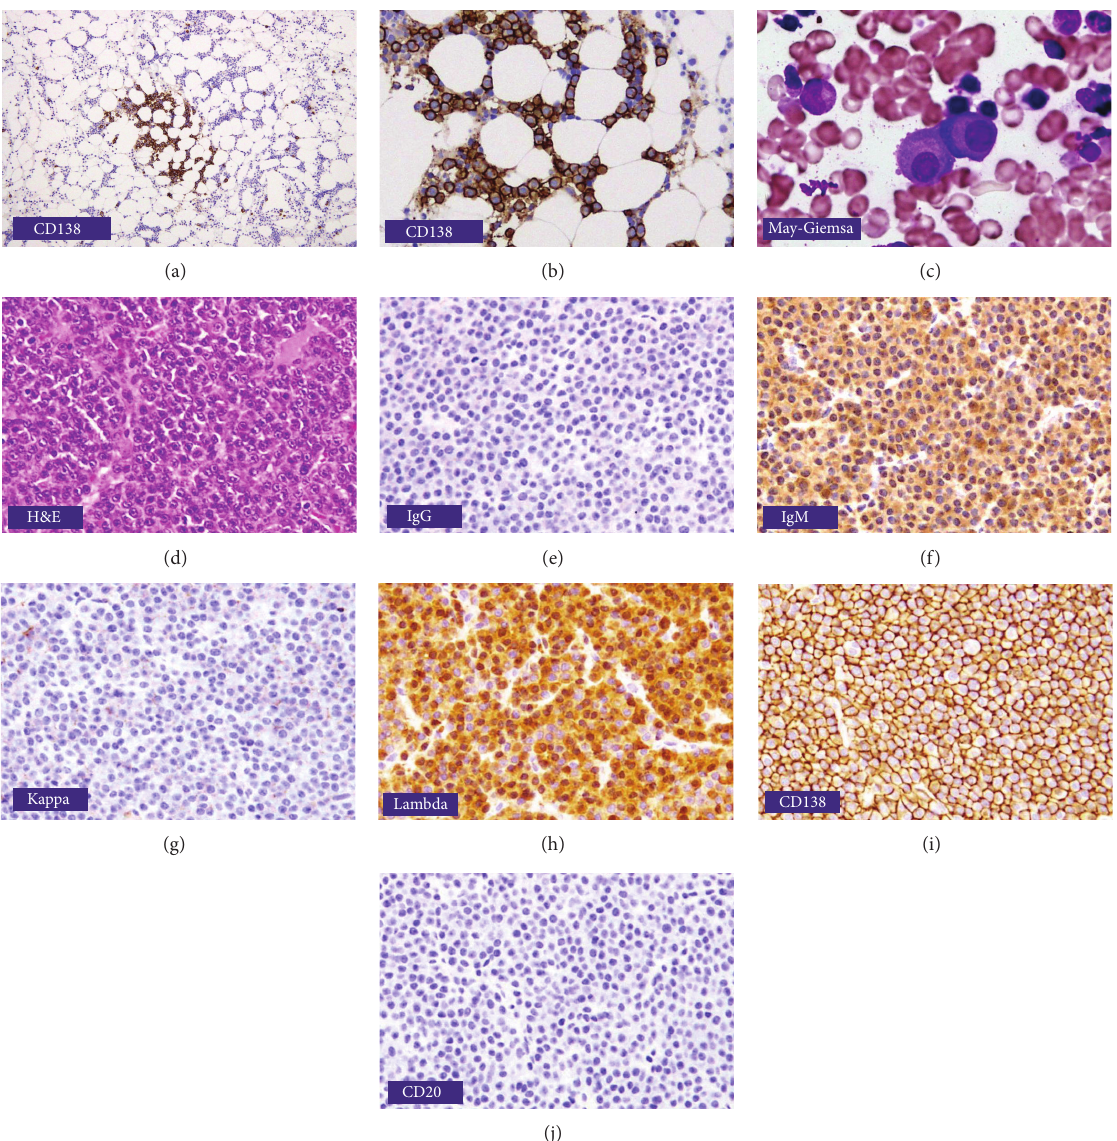
Figure 3: Bone marrow and specimen from the sacral mass. ((a), (b)) Immunostaining for CD138 in the bone marrow clot section showing microcluster infiltration of plasma cells (x40, x200). (c) Bone marrow aspiration smear showing atypical plasma cells (May- Giemsa stain x600). ((d)–(j)) Specimen of sacral mass. (d) Hematoxylin and eosin (H&E) stain showing diffuse infiltration of plasma